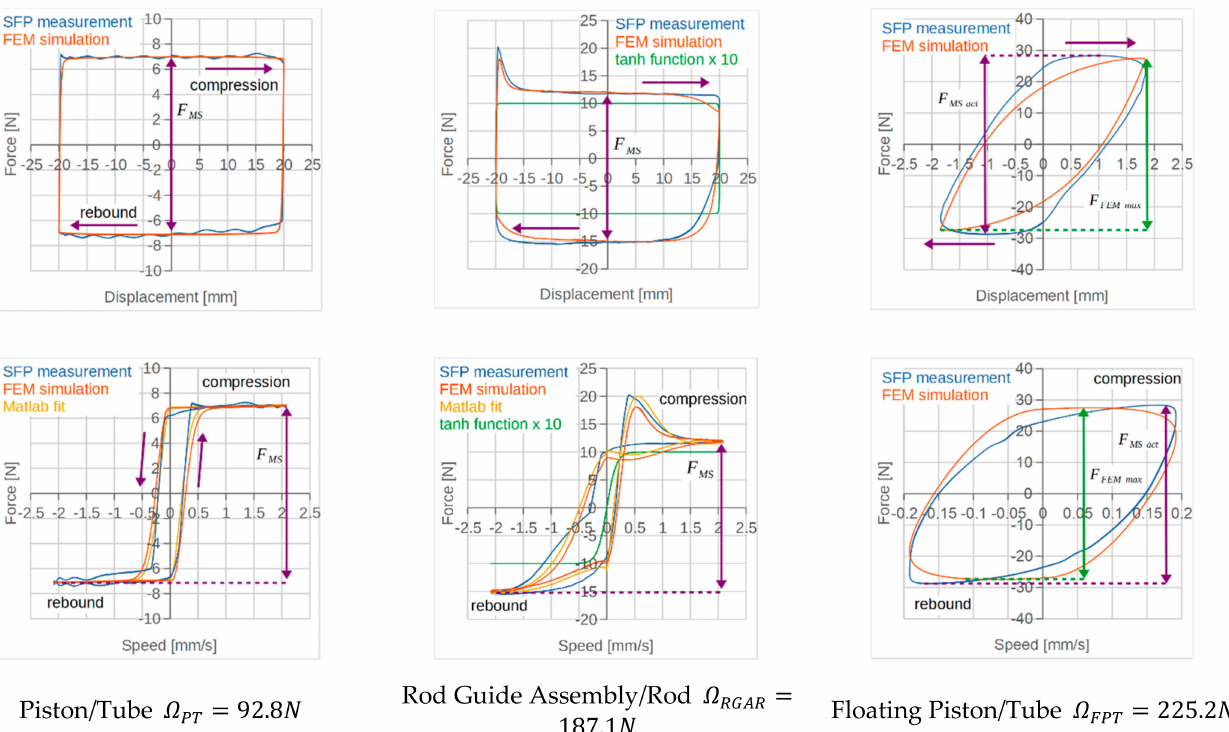
Figure 10. Comparison of the FEM simulations and the single friction point measurements of the friction behavior of all three friction